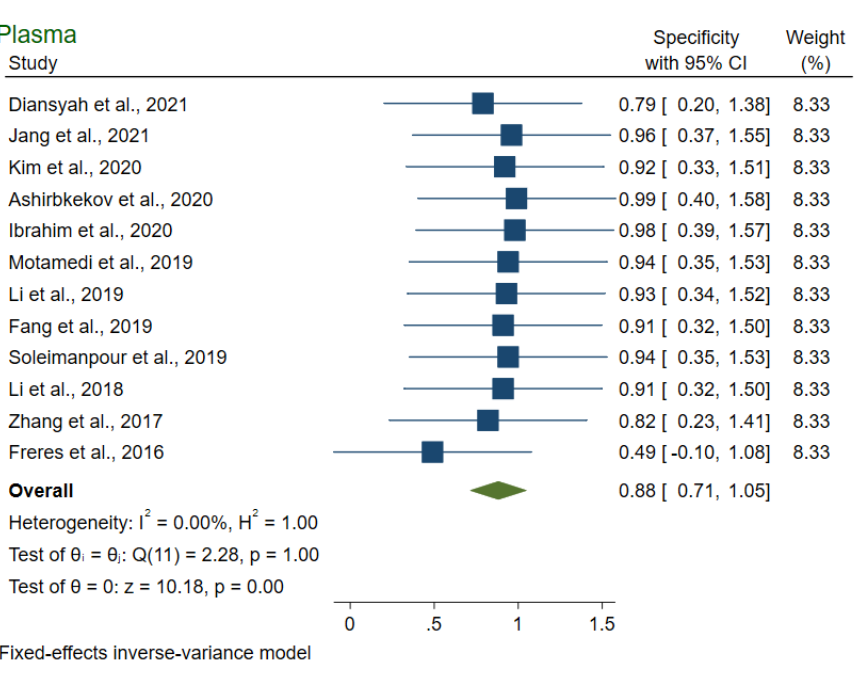
Fig. 7. Specificity of circulating microRNAs on plasma models.